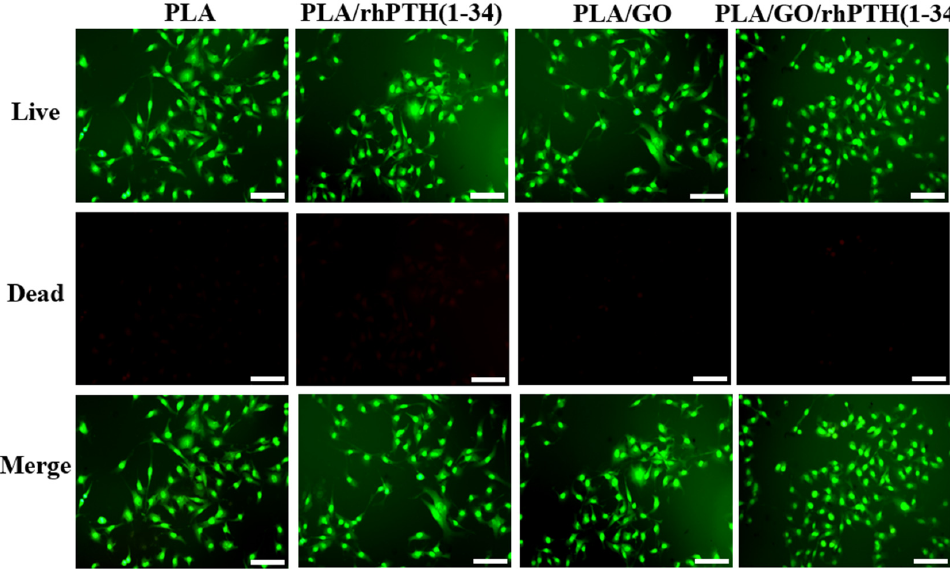
Figure 6. AO/EB staining assay of MC3T3-E1 cells cultured with various samples (100× magnifica- tion, Bar = 100 µm).